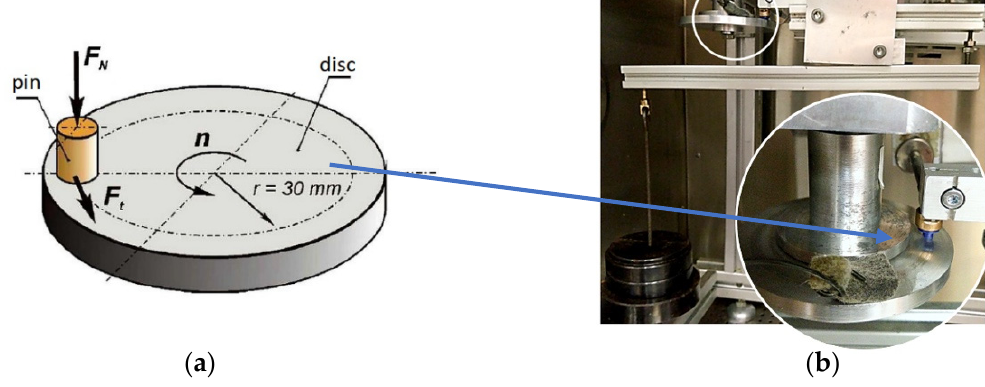
Figure 2. Pin-on-disc sliding pair: ( a ) scheme, ( b ) photos of test stand measuring head inside the chamber.